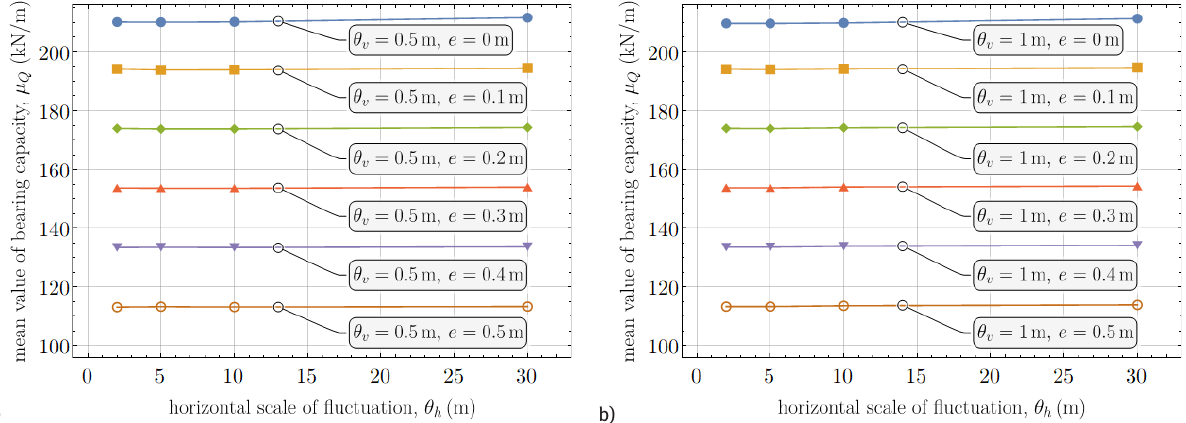
on the mean value μ h